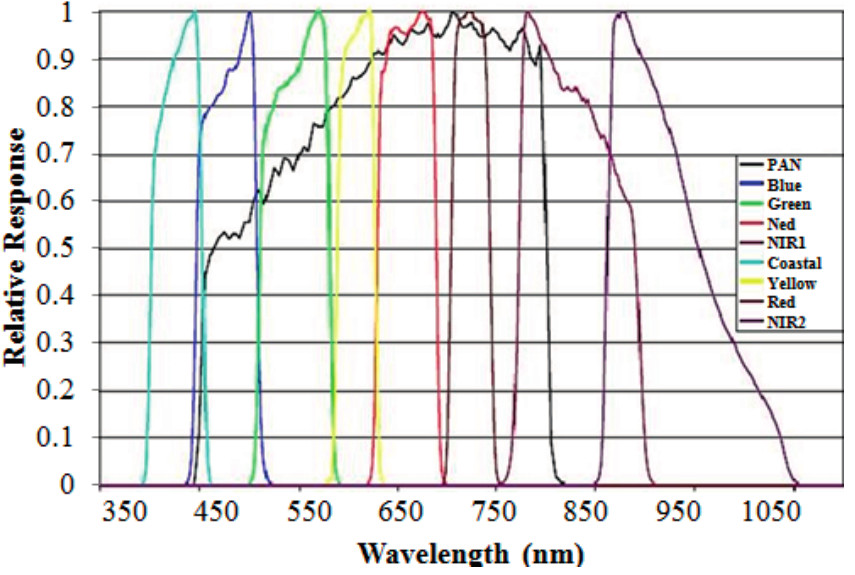
Figure 2. Relative spectral radiance response of the WorldView-2 instrument. The bandwidths are Coastal: 400–450 nm, Blue: 450–510 nm, Green: 510–580 nm, Yellow: 585–625 nm, Red: 630–690 nm, Red Edge: 705–745 nm, NIR1: 770–895 nm and NIR2: 860–1040 nm. (Image credit: Digital